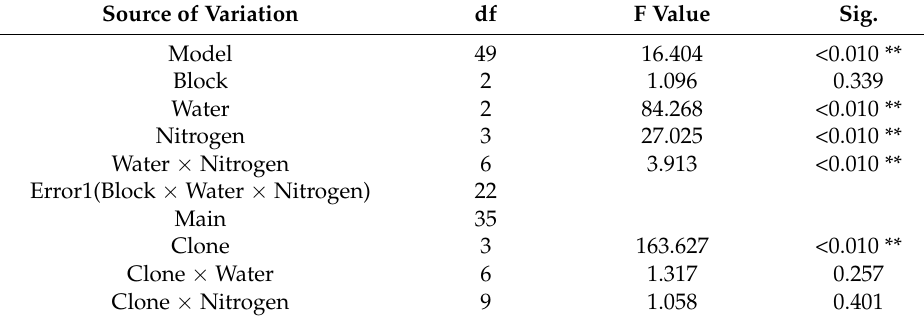
Table 3. Analysis of variance (ANOVA) summaries for stand volume increment in October 2014 in relation to irrigation, nitrogen application clone, block since